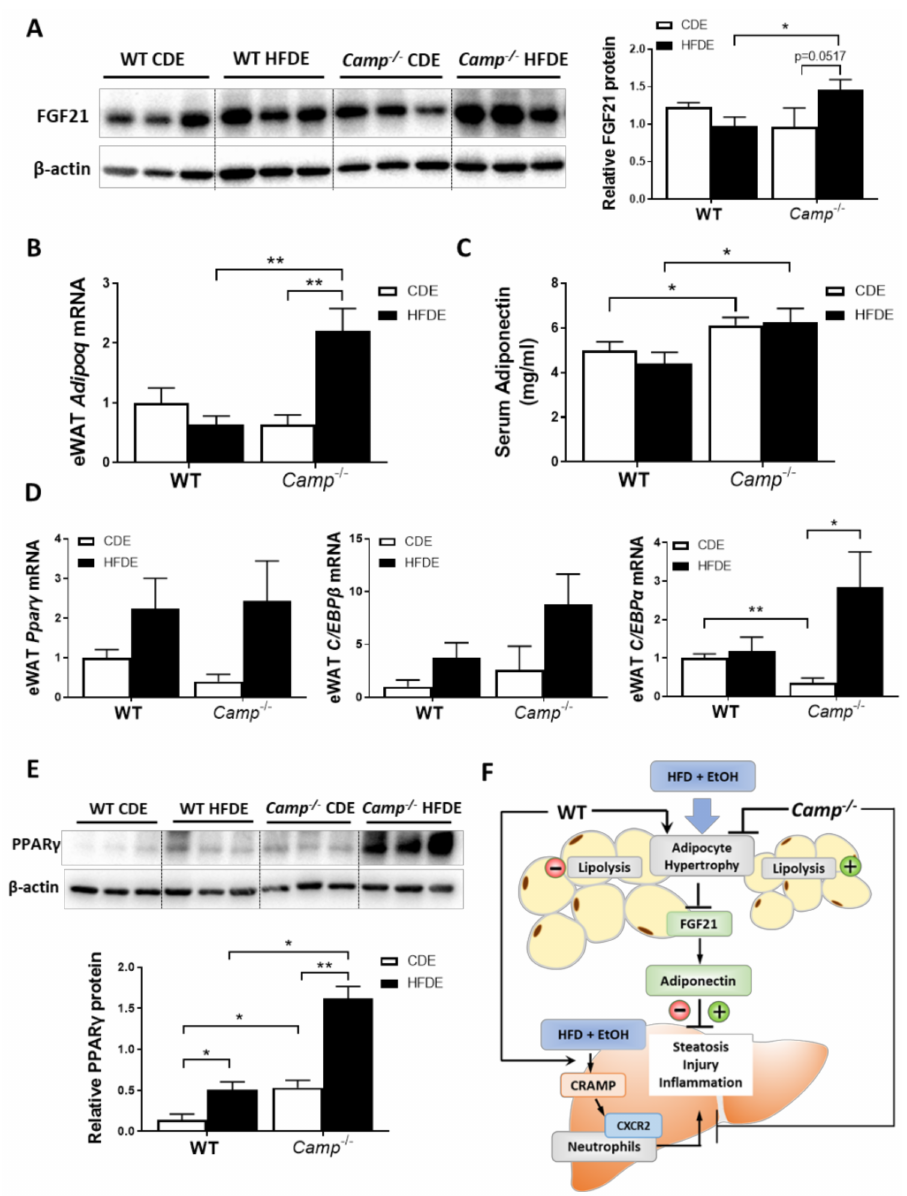
Figure 6. HFD feeding plus alcohol promoted FGF21/adiponectin upregulation in Camp –/– mice. ( A ) Representative images of eWAT FGF21 immunoblotting (left panel) and its quantification (right panel). ( B ) eWAT Adipoq mRNA levels. ( C ) Serum adiponectin protein levels, n = 6–9. ( D ) Relative mRNA level of Pparg , Cebpb and Cebpa in eWAT. ( E ) Representative Western blots for PPAR γ protein level (upper panel) and quantification (lower panel) in eWAT. ( F ) Schematic hypothesis of the protective effects of CRAMP deficiency in HFDE-induced liver steatosis, injury and inflammation. Data are expressed in Mean ± SEM (n = 5 mice/group). * p ≤ 0.05, ** p ≤